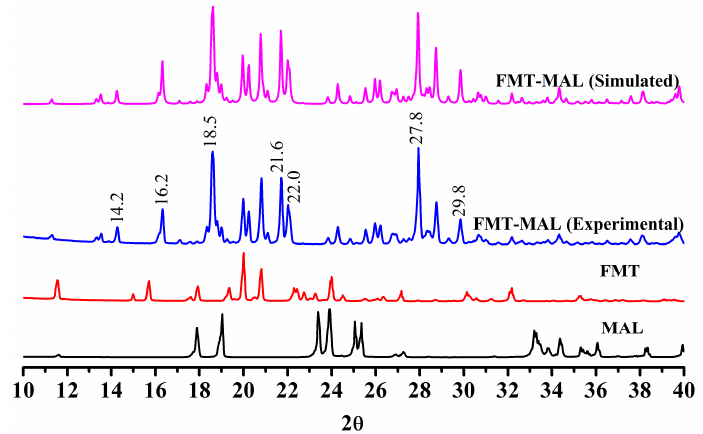
Figure 2. PXRD patterns of FMT-MAL (simulated), FMT-MAL (experimental), FMT, and MAL. The FMT-MAL was a colorless block, unlike the colorless needle of FMT. X-ray structural analyses revealed that FMT-MAL crystallizes in a non-standard space group ( P 2 1 /n). Crystal data for